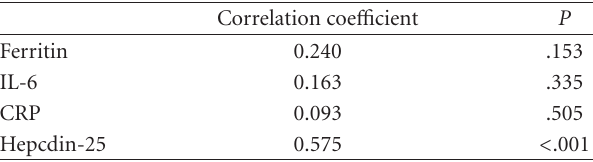
Table 3: Correlations between serum hepcidin-20 levels, inflamma- tion indices, and serum hepcidin-25 in HD